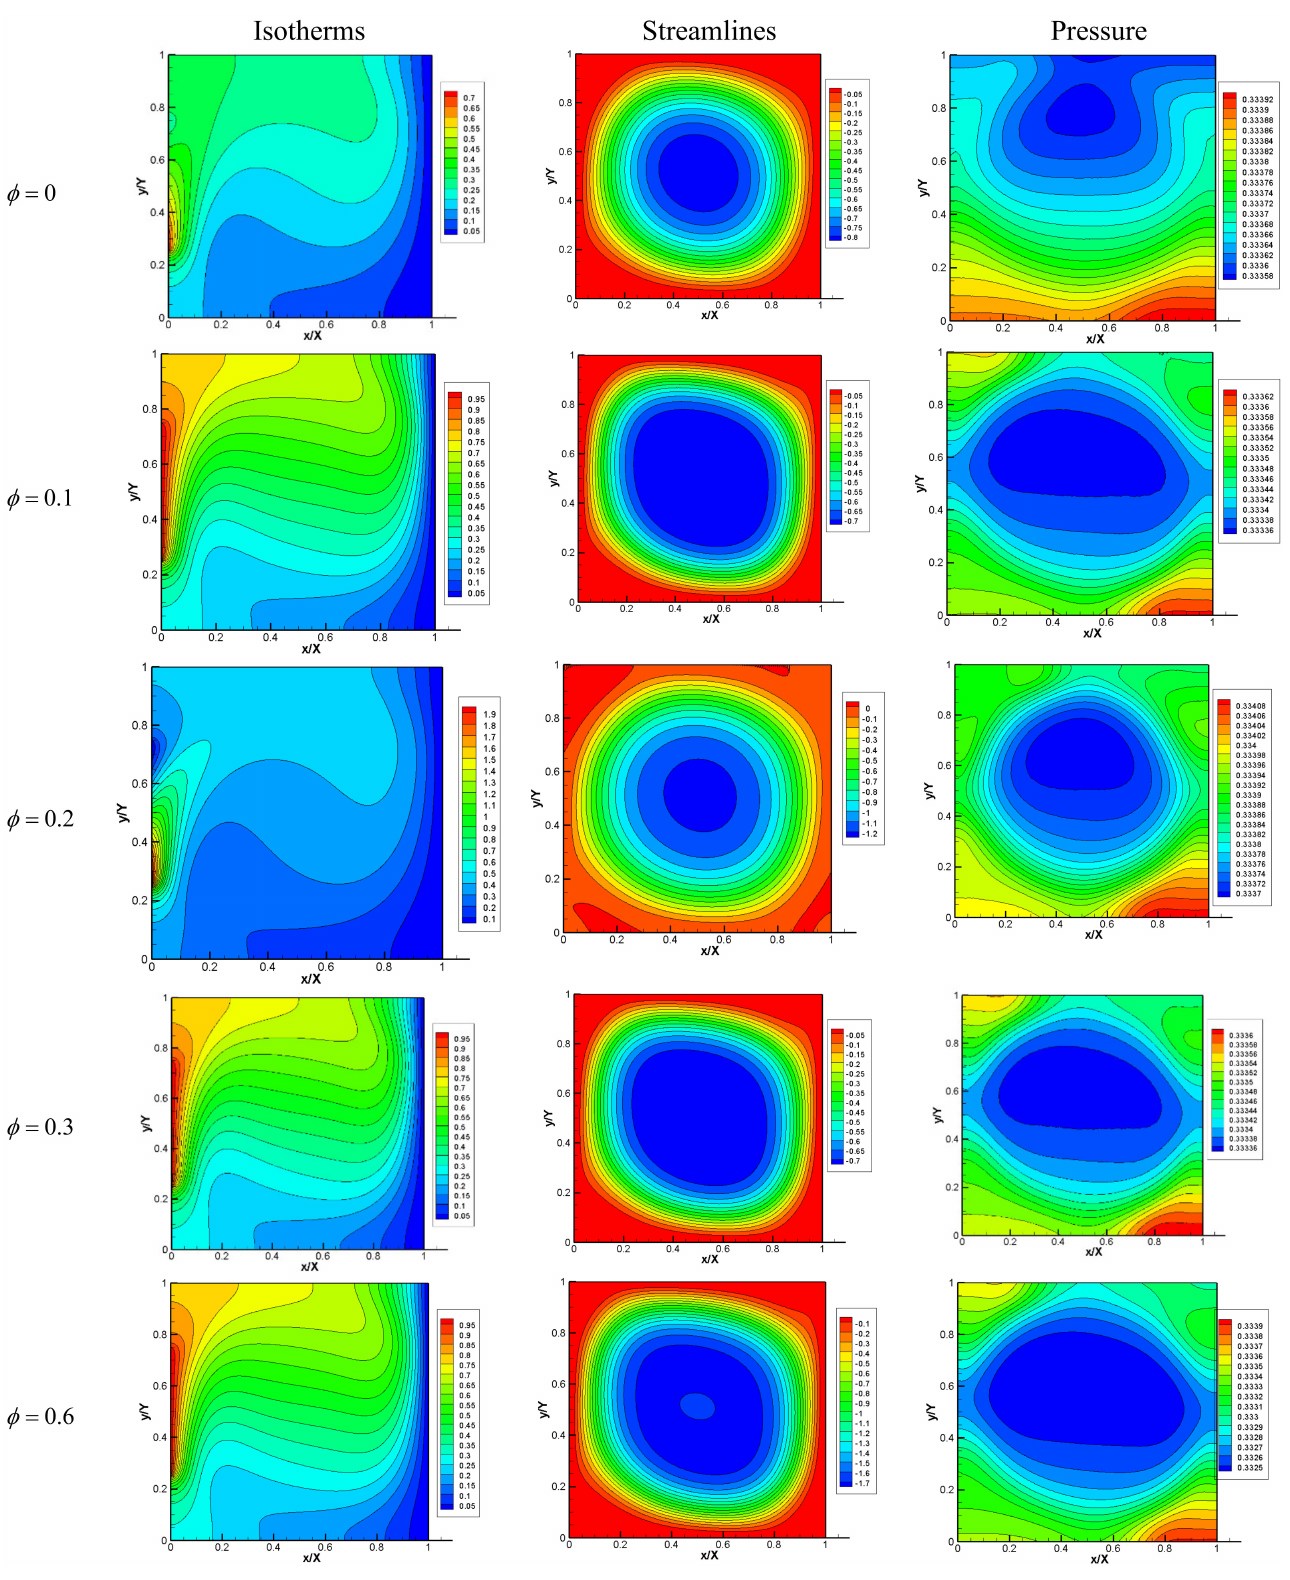
Figure 15. Steady state isotherm, streamline, and pressure profile behavior for central partially left boundary conditions (case 3: sinusoidal boundary condition) at different volume fractions ( φ ) for Ra = 10 5